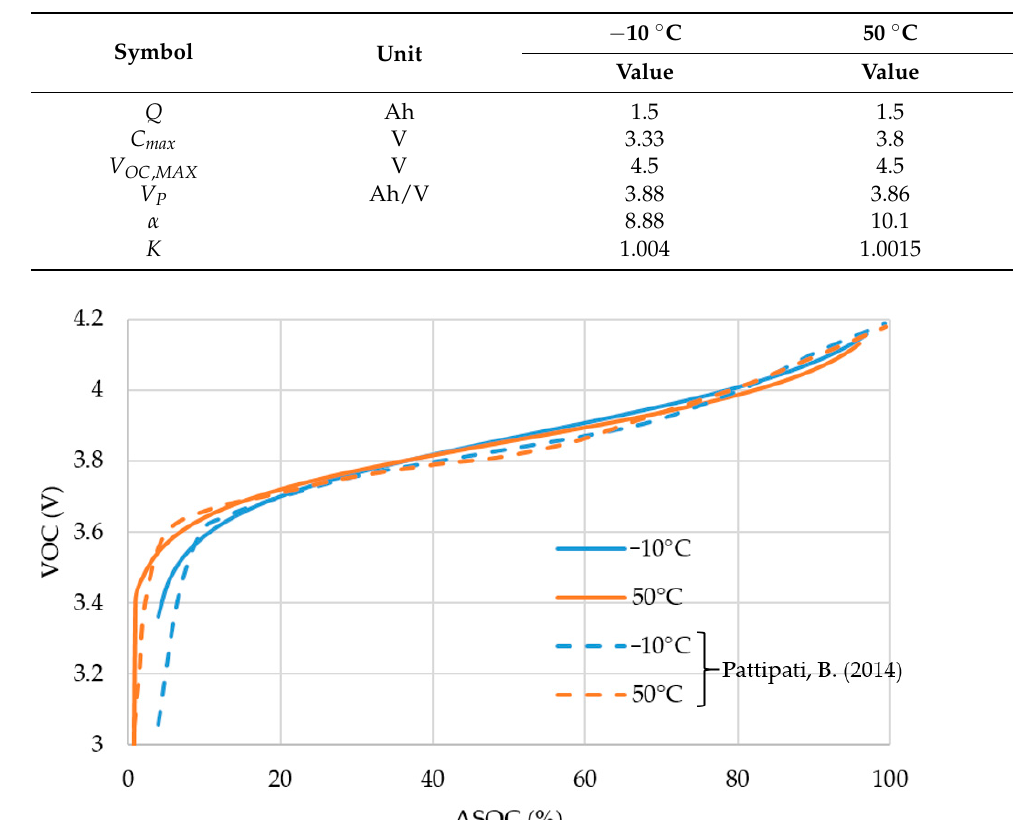
Table 5. Parameters under different operating temperatures.